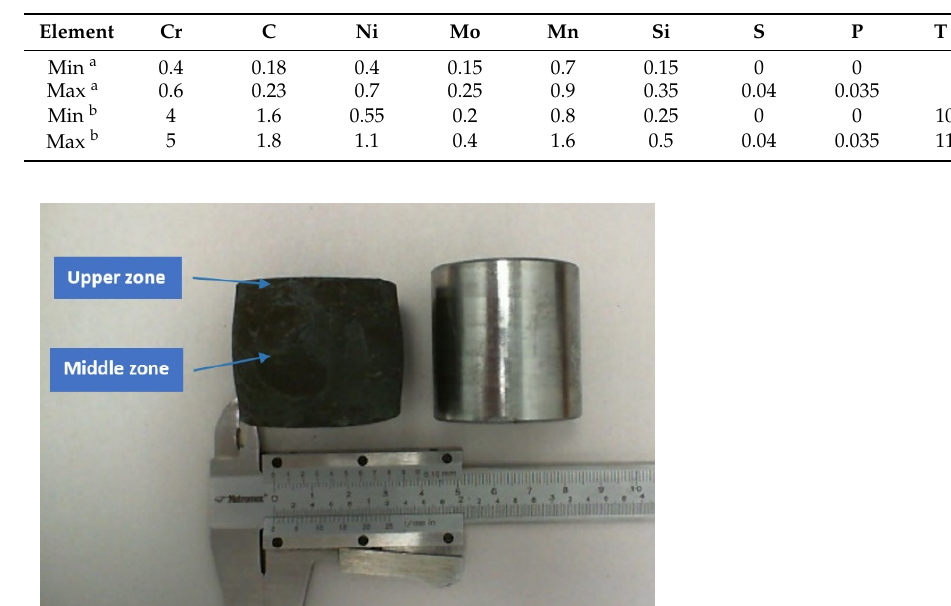
Table 2. Nominal composition of 8620 steel [14] (a) and the two-level DOE values for eight alloying elements (mass %) and temperature (b).